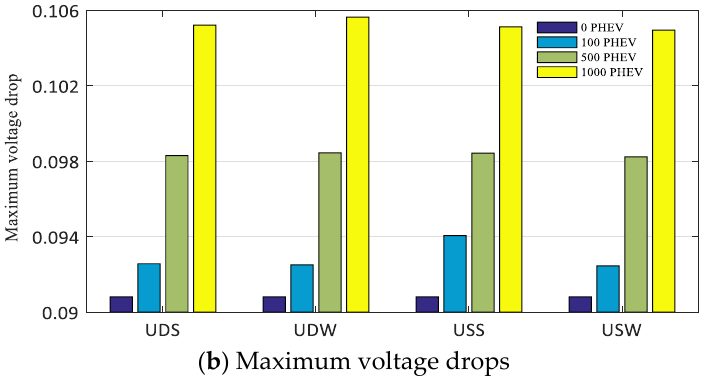
Figure 6. Voltage drop of the distribution grid buses.